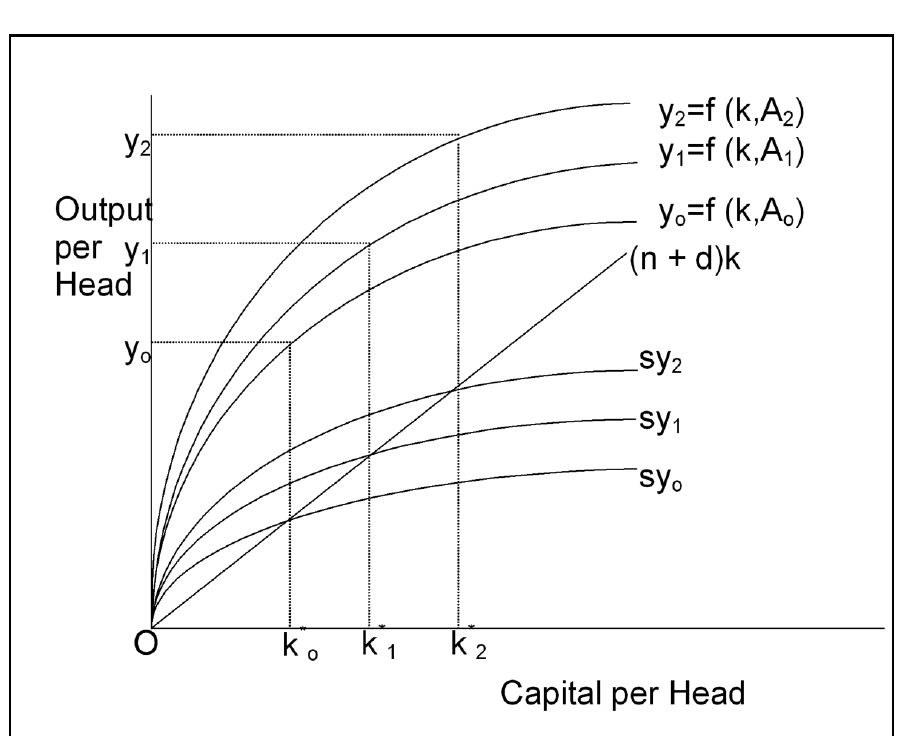
Figure 6. Endogenous